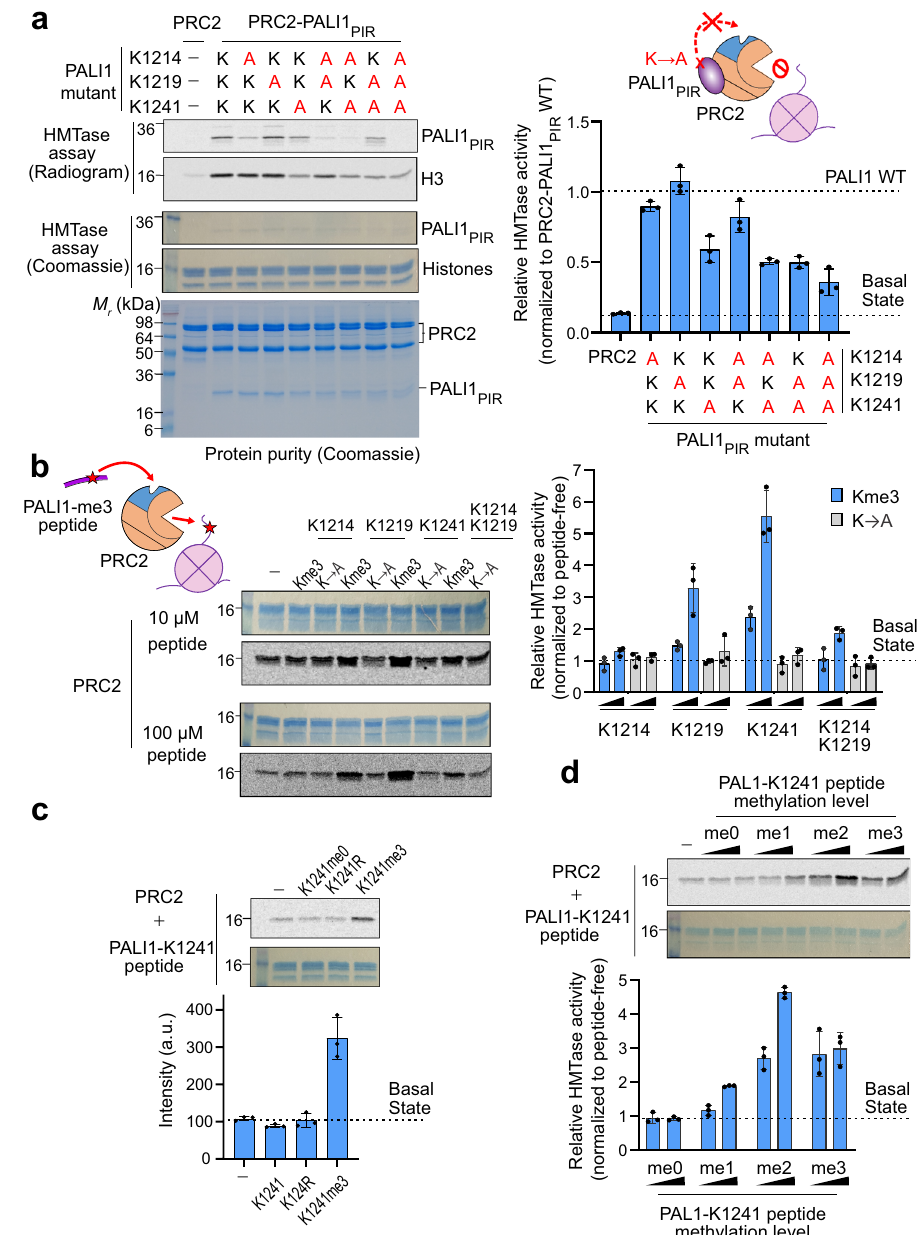
Fig. 2 PALI1 K1241 is required and PALI1-K1241me2/3 is suf fi cient to stimulate the HMTase activity of PRC2. a HMTase assays were carried out using 500 nM of wild-type or mutant recombinant complexes, as indicated, using 2 µ M mononucleosomes substrate. The bar plot (right) represents mean HTMase activities, quanti fi ed using densitometry and normalised to the activity of the wild-type PRC2-PALI1 PIR. Dash lines indicate the activity of the wild- type PRC2-PALI1 PIR (upper line) and the core PRC2 (bottom line) complexes. b HMTase assay performed with 500 nM PRC2, 2 µ M mononucleosomes and in the presence or absence of either 10 µ M or 100 µ M PALI1 peptide, as indicated. The bar plot (right) represents the relative HMTase activities of PRC2 in the presence of tri-methylated (blue) or K-to-A mutated (grey) PALI1 peptides, as indicated. c HMTase assays of PRC2 performed as above, in the presence or absence of PALI1-K1241 peptides, as indicated. d HMTase assays of PRC2 performed as above, in the presence or absence of PALI1-K1241 peptides with different methylation states, as indicated. The bar plots in b – d represents the relative HMTase activities, normalised to the HMTase activity of PRC2 in its basal state (dashed line). The numbers on the left side of the gels and radiograms in this fi gure represent the molecular weight marker in kDa. The bar plots in all panels represent the mean of the quanti fi cation performed using densitometry over three independent replicates. Error bars shown in this Figure represent standard deviation with the observed values plotted as dots. Uncropped gel images used to generate this fi gure are in Supplementary Fig. 2. Source data for this fi gure are provided as a Source Data fi